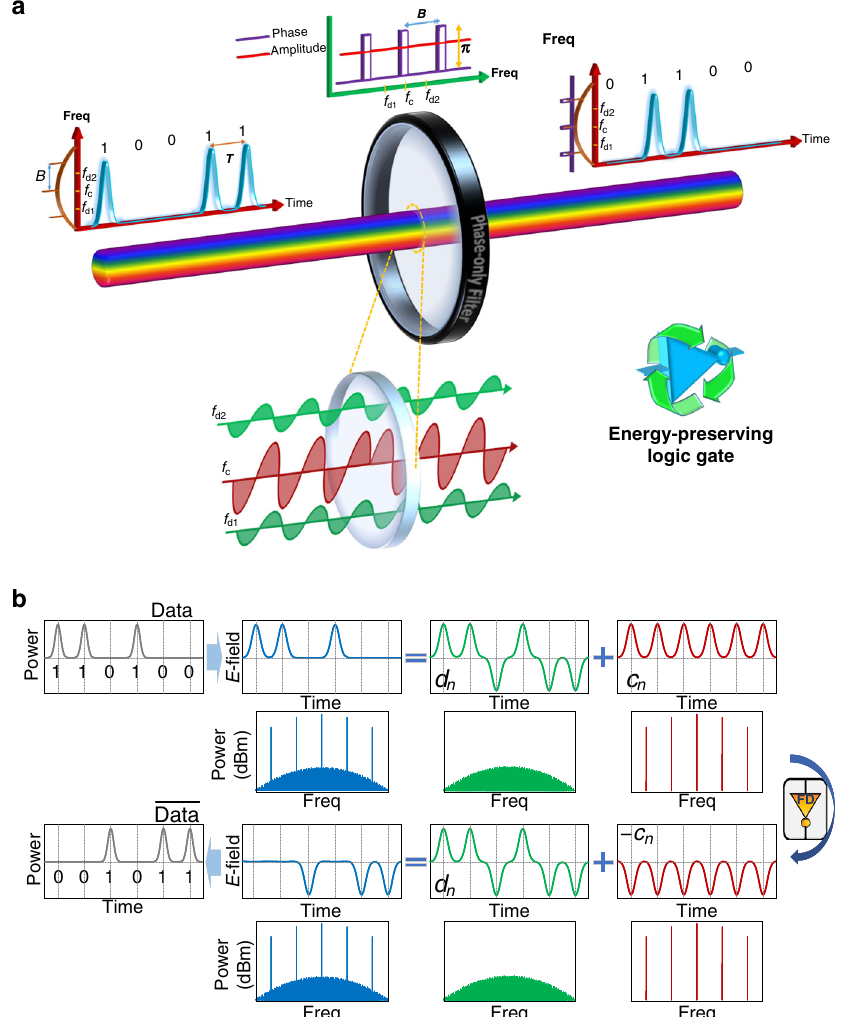
Fig. 1 The operation principle of the proposed frequency-domain zero switching-energy logic NOT gate. a A frequency-domain (FD), passive NOT gate is implemented using a lossless passive all-pass (phase-only) linear fi lter. To perform the logical NOT operation on the digital (binary) input data signal, the fi lter imparts a π phase shift to the clock components of the incoming coherent digital input with respect to the rest of the signal frequency spectrum. Through this process, the output energy spectrum remains unchanged with respect to that of the input signal; however, in the time domain, the logic states of the input bit sequence are reversed. f c (red) shows one of the frequency clock lines and f d1 and f d2 (green) represent arbitrary data frequencies. Note how f c (red) is fl ipped in orientation at the output of the fi lter compared to f d1 and f d2 . b Conceptual understanding of how amplitude-modulated data streams can be thought of as a sum of their clock, c n (red), and data, d n (green), components. The difference between Data and its inverse, Data, is a π phase shift ( fl ipping in orientation) on clock frequency tones (red) with respect to the spectral data components (green). The summation of inverted clock frequencies to the original data results in the NOT